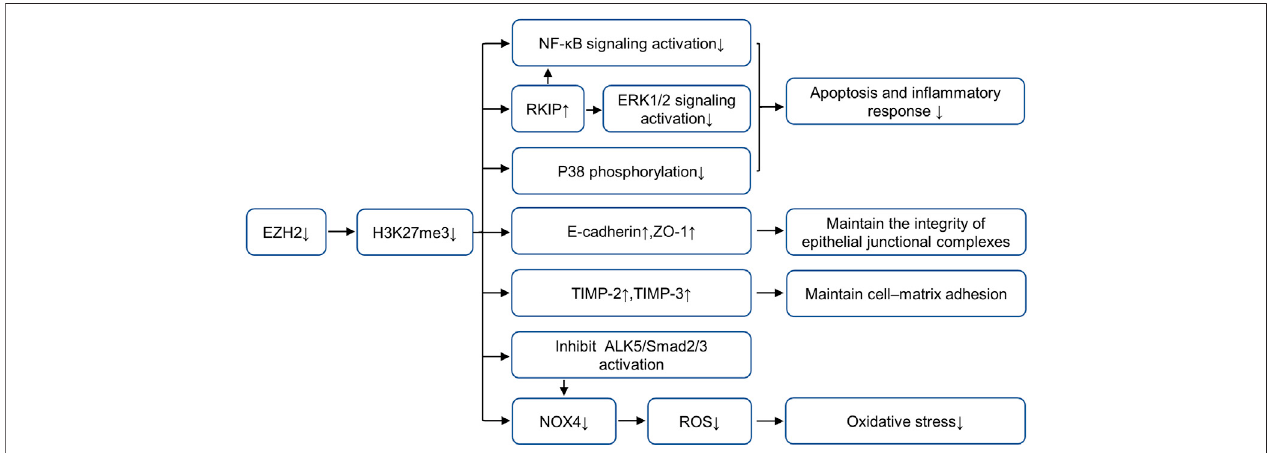
FIGURE 1 | Role and mechanism of EZH2 inhibition in AKI. EZH2 inhibition plays a protective role in acute kidney injury by preserving the expression of RKIP, E-cadherin, TIMP-2 and TIMP-3, and repressing the activation of multiple fi brosis and in fl ammatory signaling pathways, including NF- κ B, ERK1/2, p38 and ALK5/ Smad2/3. AbbreviationsAKI, acute kidney injury; EZH2, enhancer of zeste homolog 2; TIMP-2, metalloproteinase-2; TIMP-3, metalloproteinase-3; RKIP, raf kinase inhibitor protein; NF- κ B, nuclear factor- κ B; ERK, extracellular signal-regulated